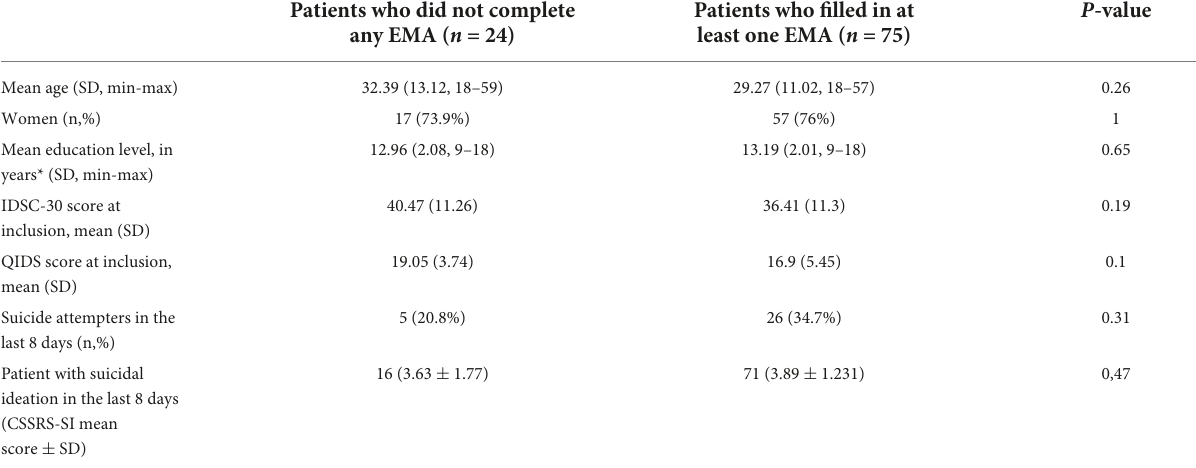
TABLE 1 Sociodemographic characteristics, depression severity, and suicidal ideation/behavior. Patients who did not complete any EMA ( n = 24)